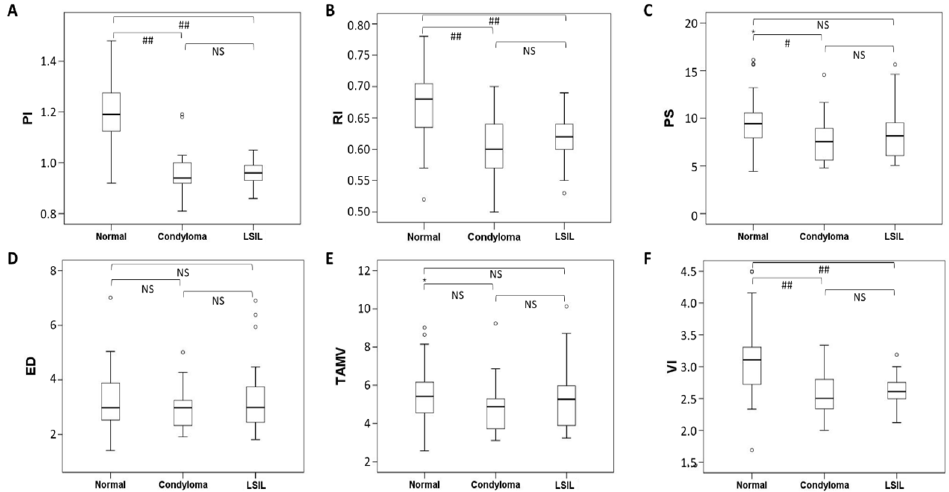
Figure 5. Box plot of the six sonographic parameters (PI, RI, PS, ED, TAMV, and VI) in the HPV condyloma subgroup ( n = 13), LSIL (CIN I) subgroup ( n = 26), and control group ( n = 40). The HPV condyloma and CIN I subgroups had lower PI, RI, and VI than the control group ( A , B , F ). ( C ) The HPV condyloma subgroup had lower PS than the control group. ( D , E ) No significant differences were observed in ED and TAMV between the HPV infection cases (HPV condyloma or CIN I) group and the control group. No significant differences in the six parameters were observed between the HPV condyloma group and LSIL (CIN I) subgroups. * Extreme outlier; ∘ , outlier. (##: p < 0.01, #: p < 0.05, NS: Nonsignificant).